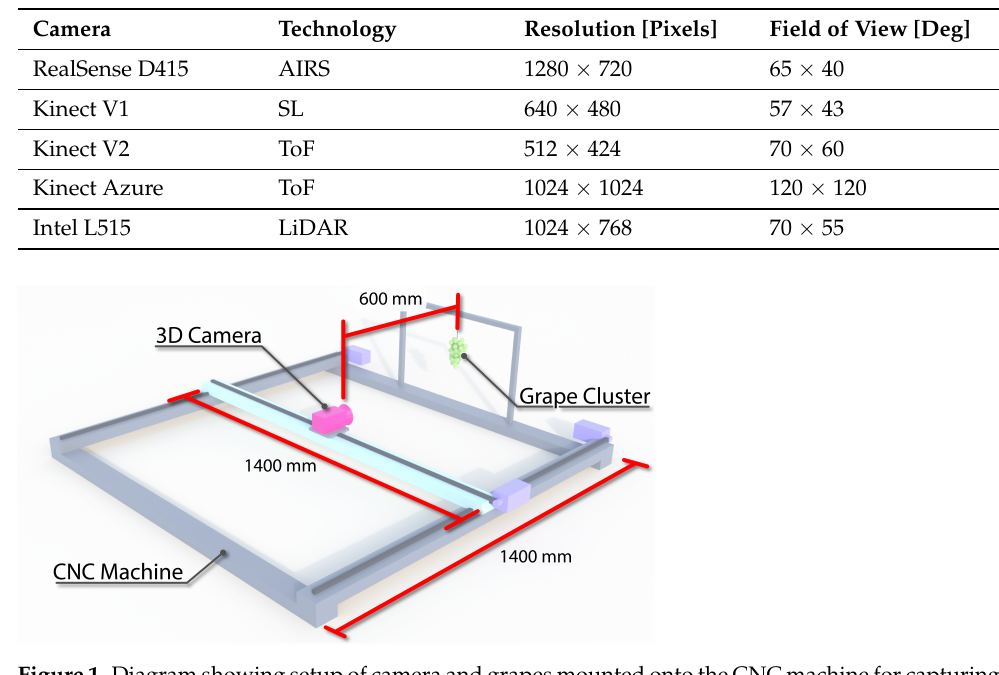
Figure 1. Diagram showing setup of camera and grapes mounted onto the CNC machine for capturing RGB-D images.